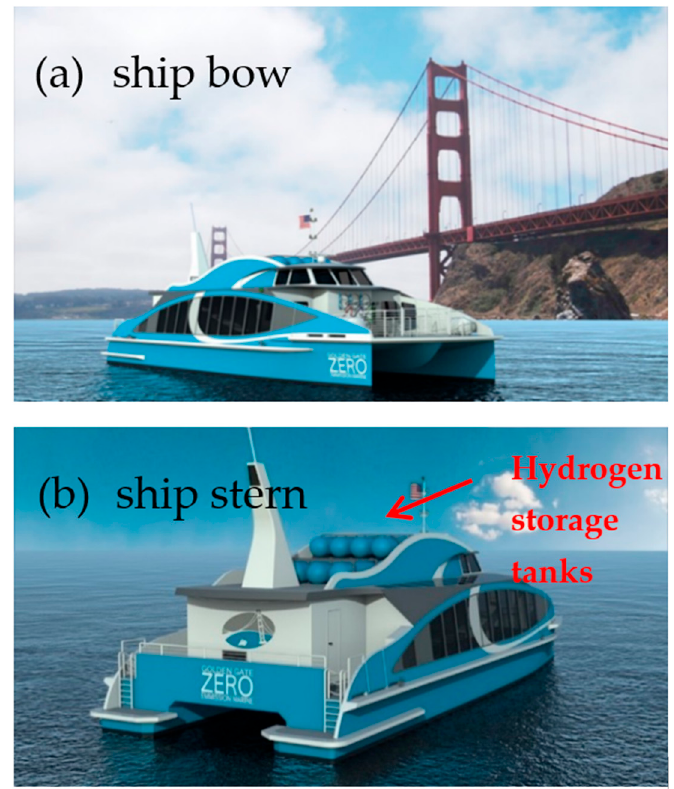
Figure 2. The conceptual design of “Water-Go-Round” [25,26].